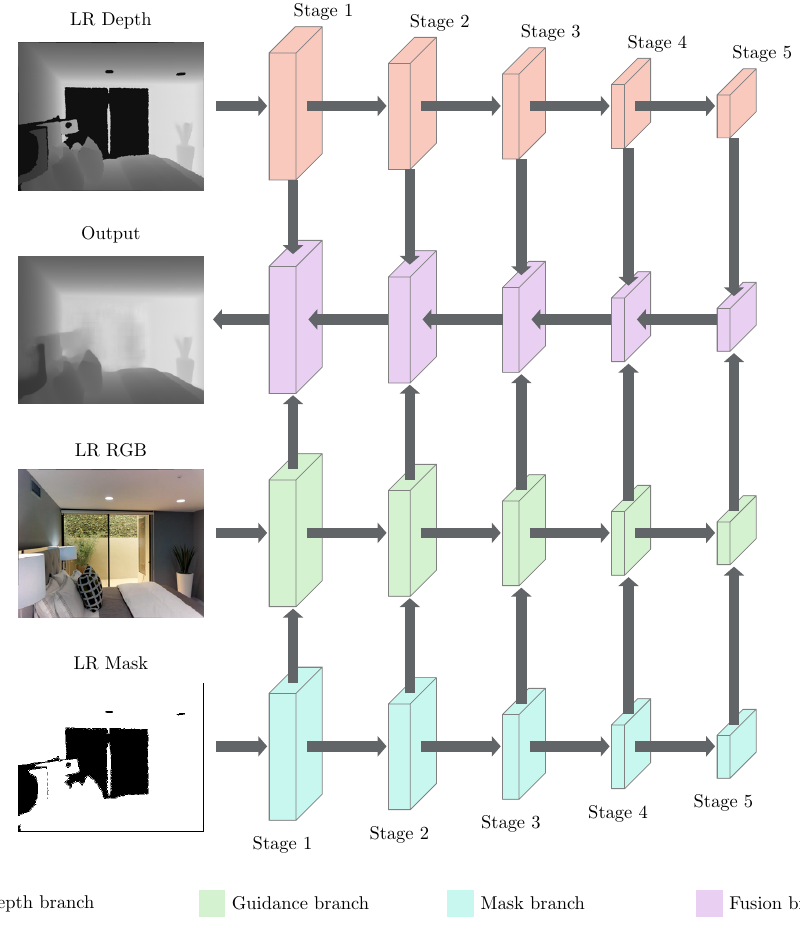
Figure 2. Architecture of the Depth Completion Module. The module consists of four DCNN branches: A Depth branch, a Guidance branch, a Mask branch, and a Fusion